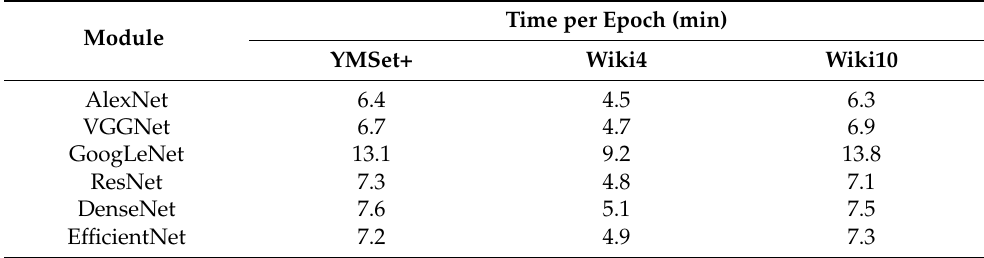
Table 1. Time required for training a network for one epoch.